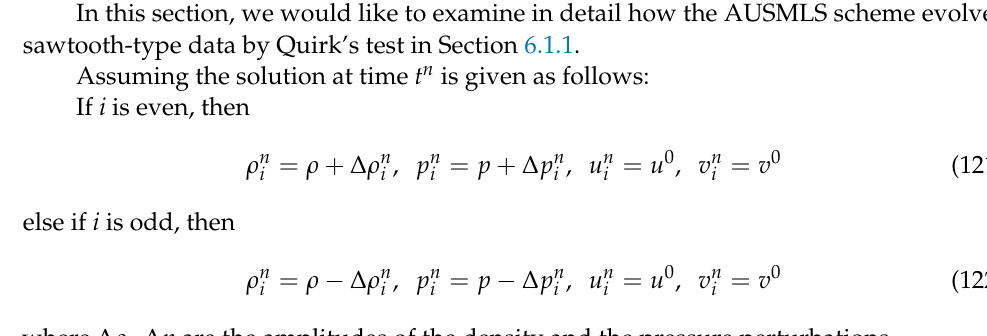
Figure 6. Density contours of the odd–even grid perturbation problem ( M s = 6.0).